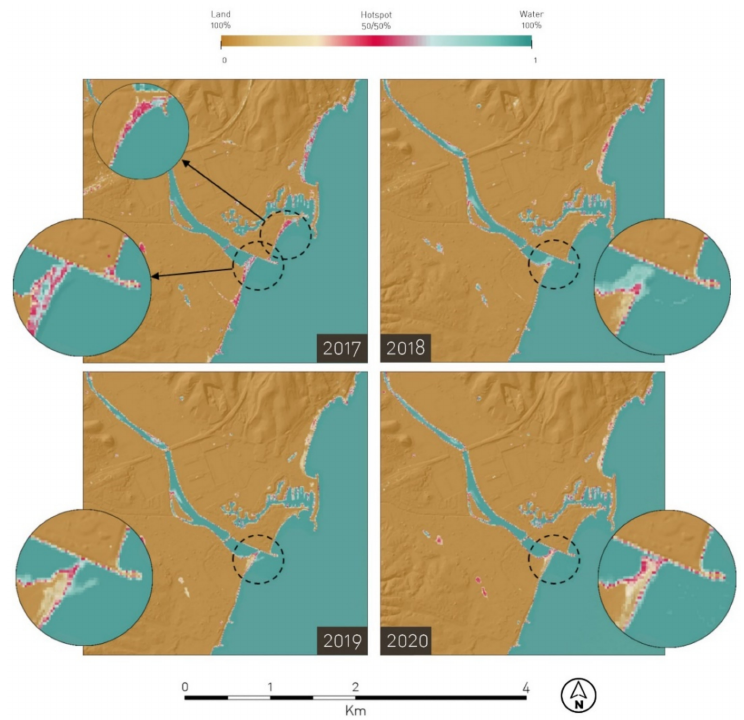
Figure 10. Annual variation rate of land/sea interface in the Guadiaro river mouth using Sentinel-2 L2A images and NDWI index (single year VR from 2017 to 2020). Scale 1:15,000.